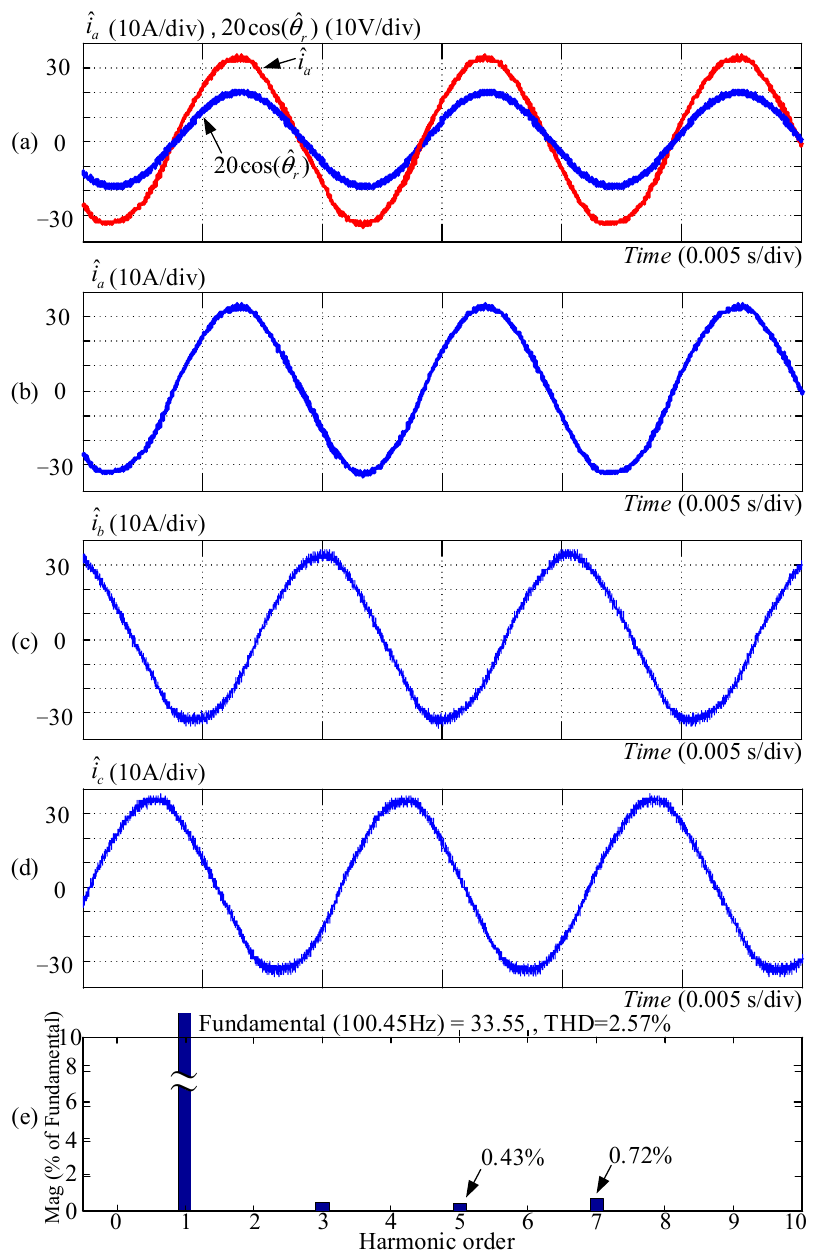
Figure 10. Measured phase currents of a three-phase permanent-magnet synchronous motor driven at 1500 rpm with compensation strategy for harmonic components in induced EMF along the a-axis, b-axis, and c-axis: ( a – d ) measured phase current ˆ i a , ˆ i b and ˆ i c ; ( e ) spectrum of phase current ˆ i a .